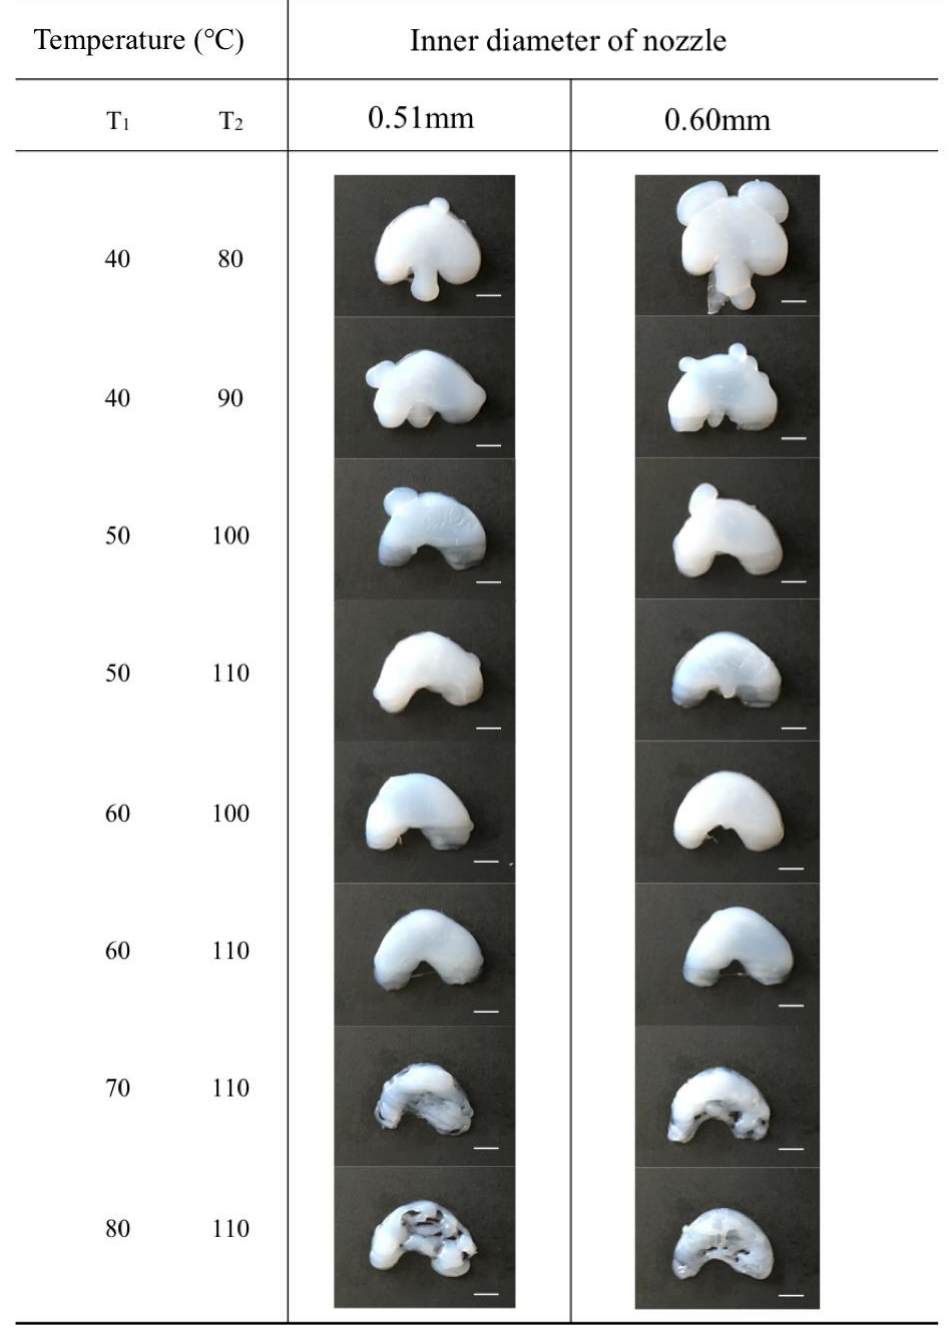
Figure 9. Top view images of the 3D printed silicone meniscus under varied heating temperature ( T 1 = nozzle temperature and T 2 = platform temperature) and inner nozzle diameter. Scale bar: 1 cm.